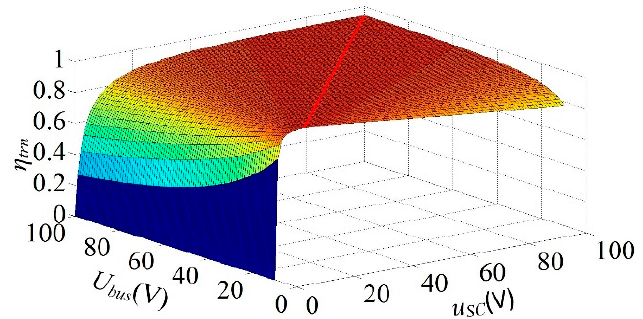
Figure 7. Transfer efficiency vs. U bus and u SC .